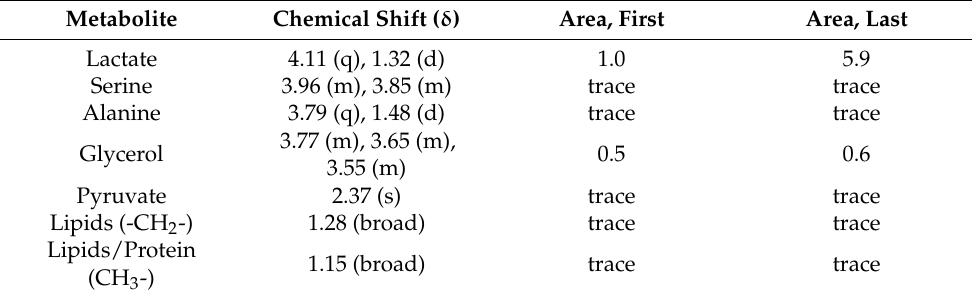
The relative area is calculated per